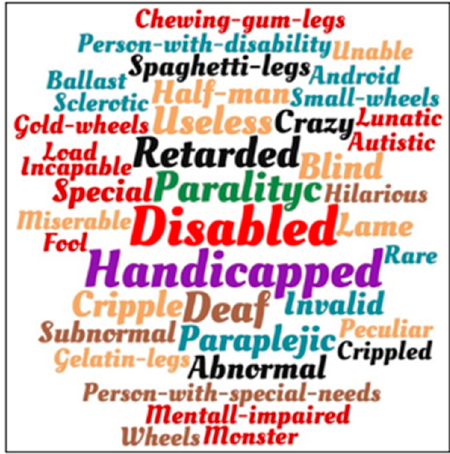
Figure 1. Most used words. Source: Own elaboration.